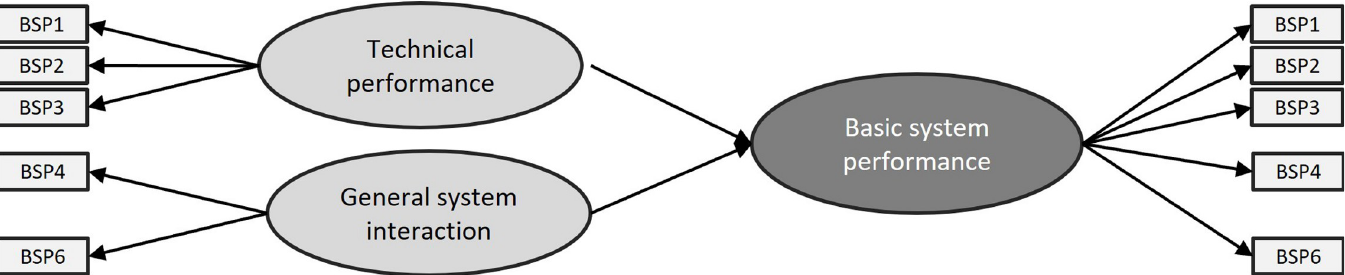
Fig 3. Reflective model of the category ‘Basic System Performance’ without item BSP5.